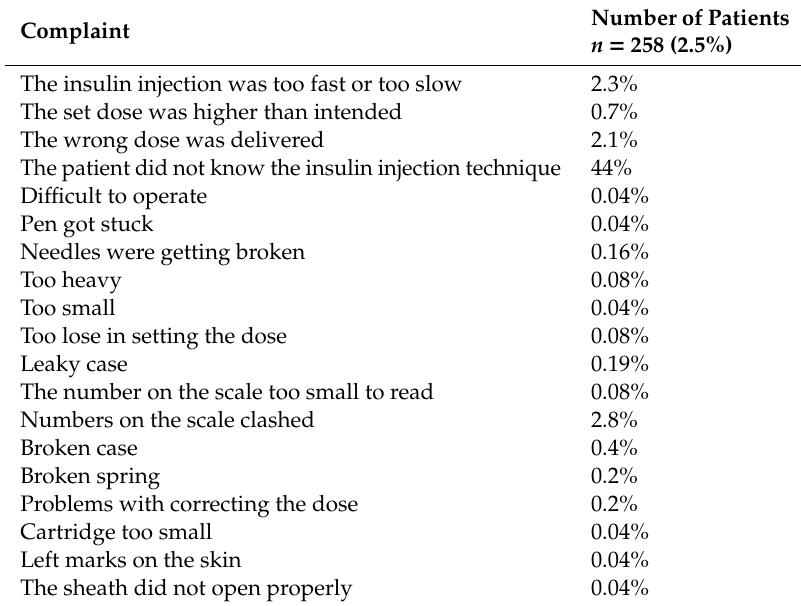
Table 1. Complaints related to previously used insulin pen injectors.